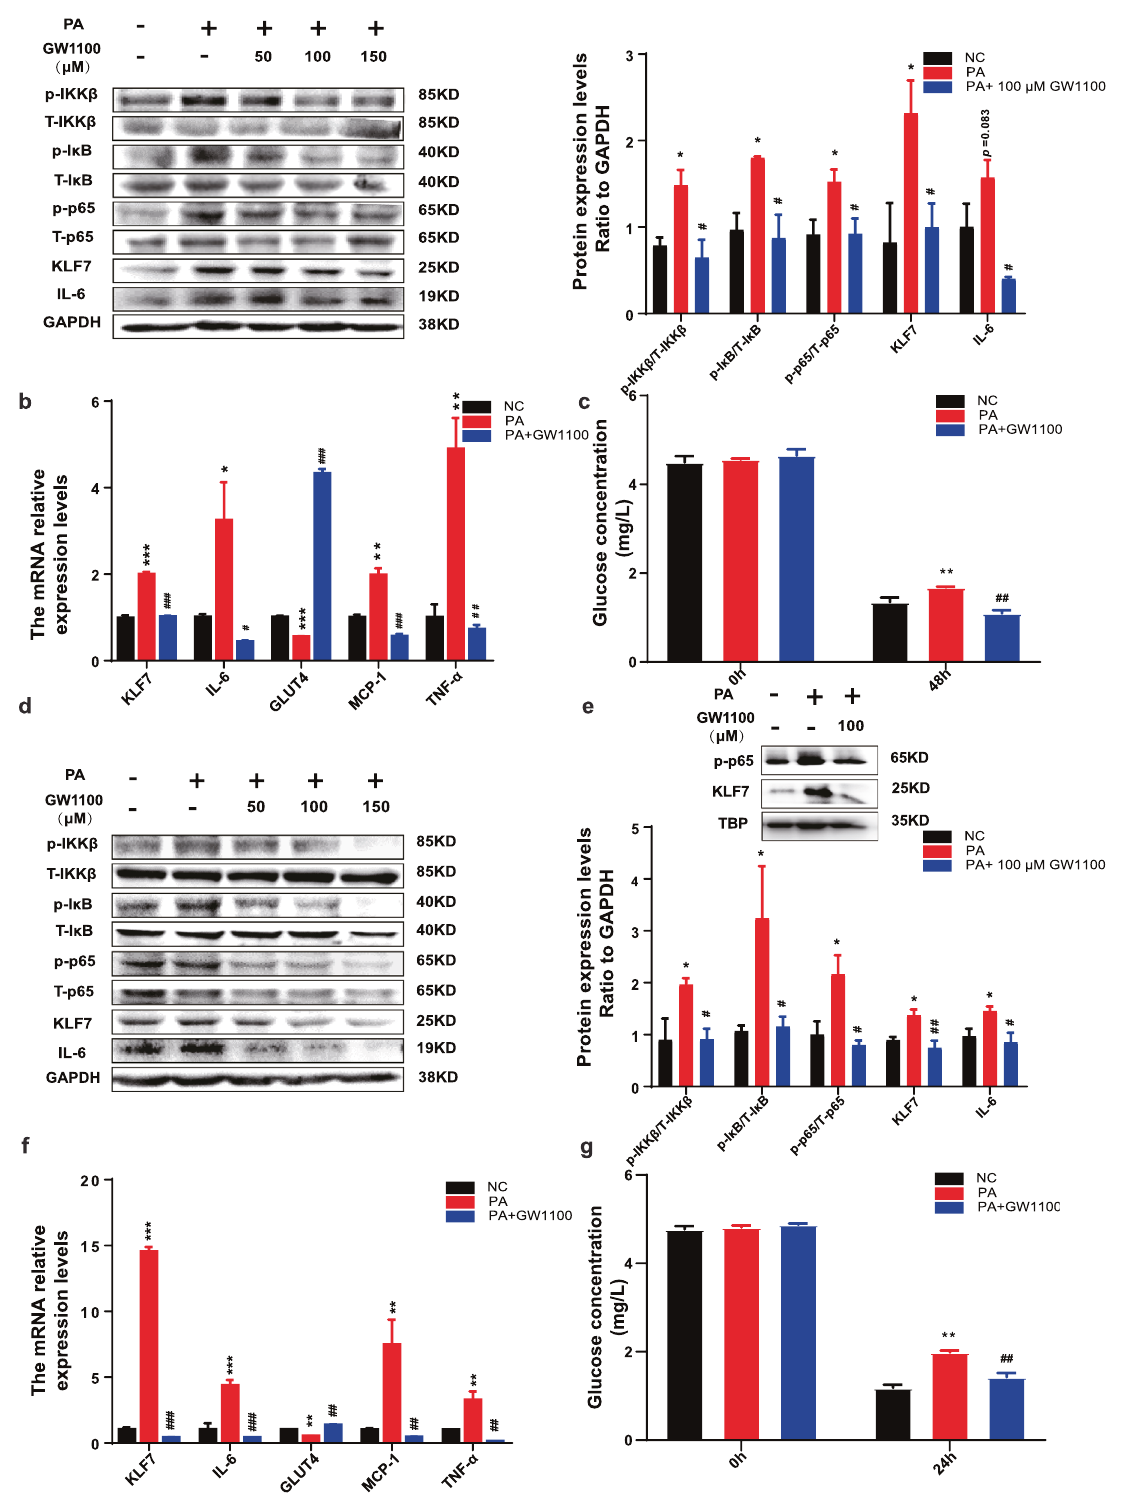
Fig. 1 PA regulates KLF7 through GPRs/p-p65 signaling pathway. Add GW1100 (50, 100, 150 μ M) to culture medium while stimulated by 200 μ M PA, the protein expression levels of p-IKK β /T-IKK β , p-I κ B/T-I κ B, p-p65/T-p65, KLF7 and IL-6 in 3T3-L1 adipocytes ( a ) and HepG2 cells ( d ). The mRNA expression levels of KLF7, IL-6, GLUT4, MCP-1 and TNF- α in 3T3-L1 adipocytes ( b ) and HepG2 cells ( f ). The expression levels of KLF7, p-p65 in HepG2 nuclear extracts ( e ). The glucose consumption ability in 3T3-L1 adipocytes ( c ) and HepG2 cells ( g ). One-way ANOVA-LSD, *NC compared with PA group, # PA compared with GW1100 group. * p < 0.05, ** p < 0.01, *** p < 0.001, # p < 0.05 , ## p < 0.01, ### p < 0.001, the difference was statistically signi fi cant, data presented as means ±